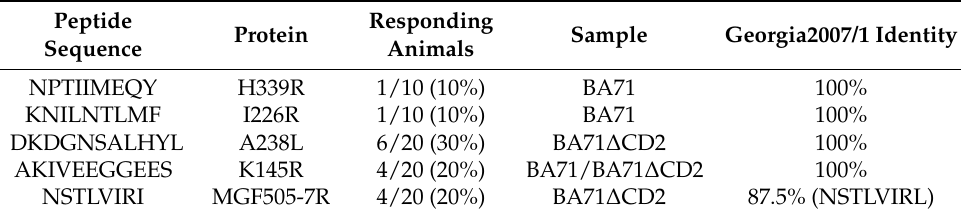
Table 3. ASFV epitopes identified by immunopeptidomics that are recognized by specific T-cells from BA71 ∆ CD2-vaccinated pigs that survived the lethal Georgia2007/1 challenge.